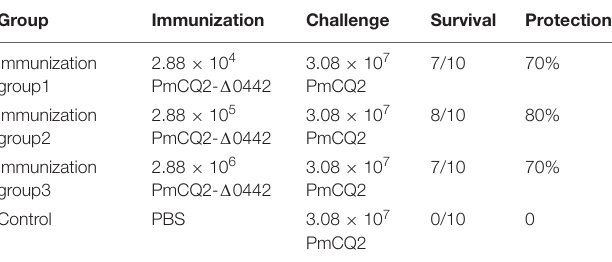
TABLE 4 | Evaluation of the protection rate conferred by PmCQ2- (cid:49) 0442 mutant.